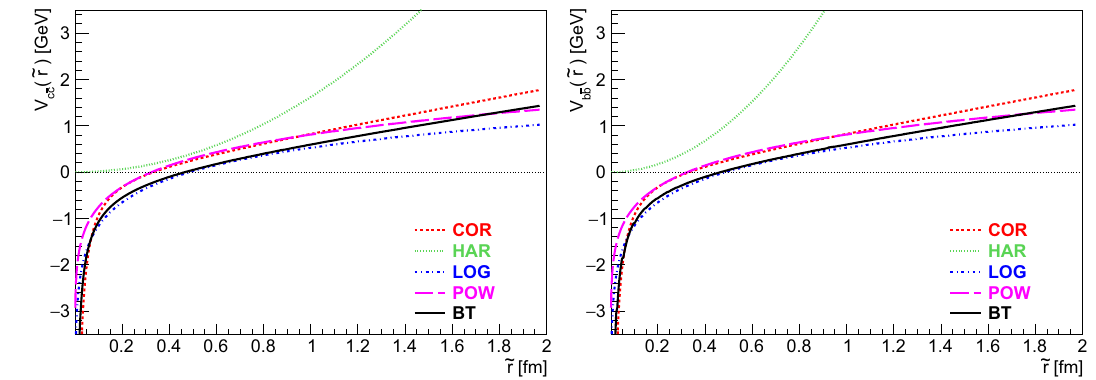
Fig. 2 An illustration of five distinct c − ¯ c (left panel) and b − ¯ b (right panel) interaction potentials, used in this work, as functions of 3D interquark distance ˜ r . For a detailed description and characteristic parameters of these potentials, see Appendix